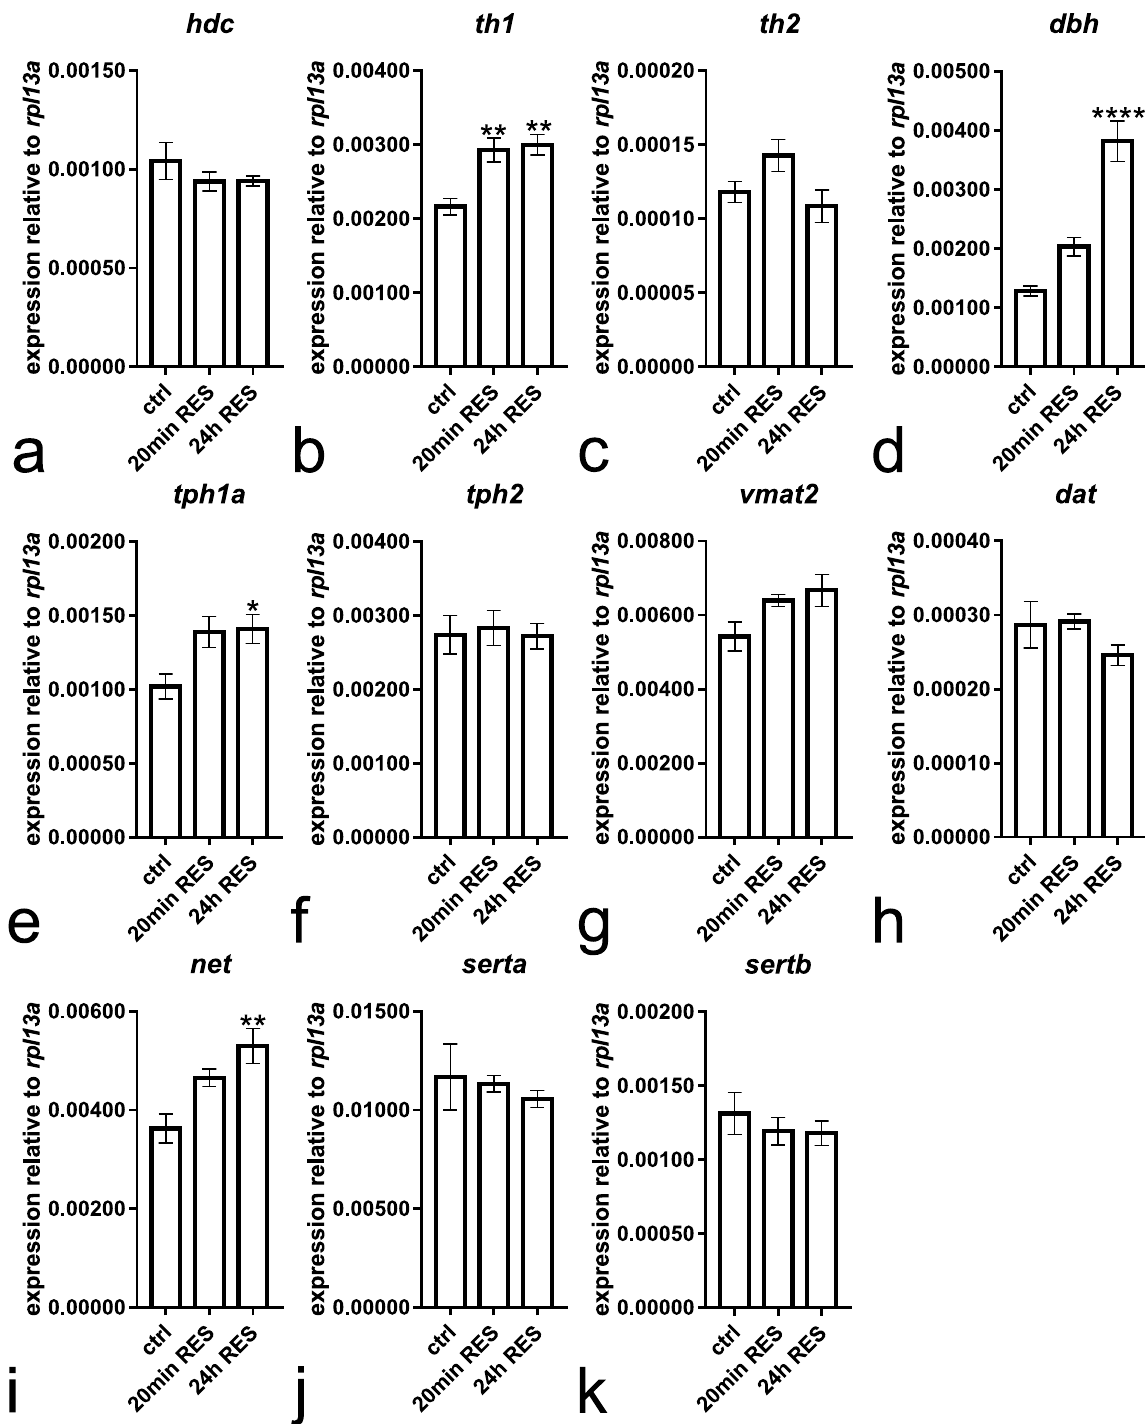
Figure 6. Analysis of mRNA expression levels 72 h after start of reserpine treatment in larvae treated for 20 min and 24 h. The rate-limiting enzyme in histamine synthesis, hdc , was not upregulated in the reserpine treated groups ( a ). The rate-limiting enzyme in dopamine synthesis, th1 , was significantly upregulated in the reserpine treated groups ( b ) whereas th2 showed no significant change in expression level ( c ). In the 24 h treated group, a significant increase was also seen in the transcript levels of dbh ( d ) and tph1a ( e ), the enzymes responsible for the synthesis of noradrenaline and serotonin, respectively. No change was seen in the expression of tph2 ( f ). Out of the monoamine transporters, only the noradrenaline transporter net was significantly upregulated in the 24 h treated group, while vmat2 , dat , serta , and sertb remained unchanged. n = 4 for controls and n = 5 for reserpine treated groups. Statistical analyses were done using 1-way ANOVA followed by Tukey’s multiple comparison test. Data presented as mean ± SEM. * p < 0.05, ** p < 0.01 and **** p < 0.0001 according to the multiple comparison test, in comparison to the control